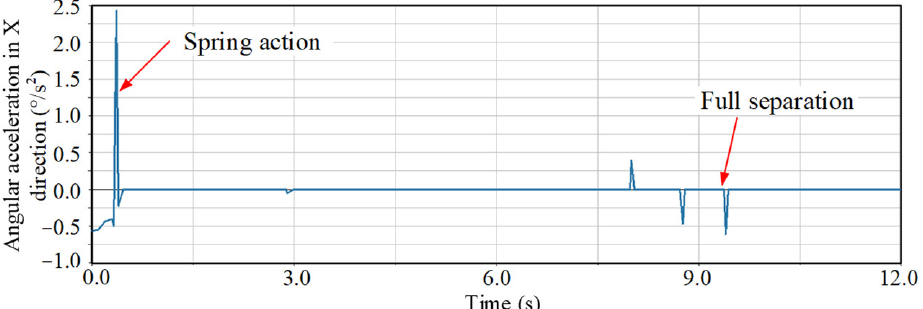
Figure 14. Variation of angular acceleration versus time.